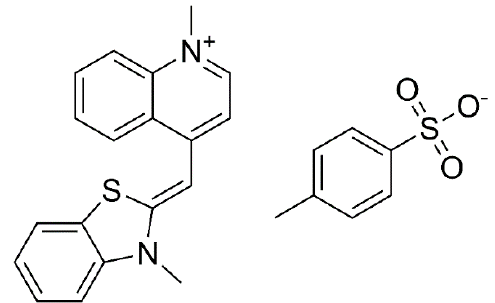
Figure 16. Chemical structures of thiazole orange (TO).